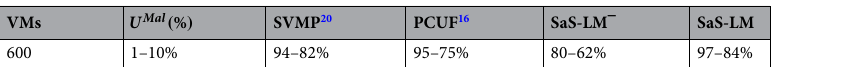
Table 6. Comparison of average co-residency resistance (%).